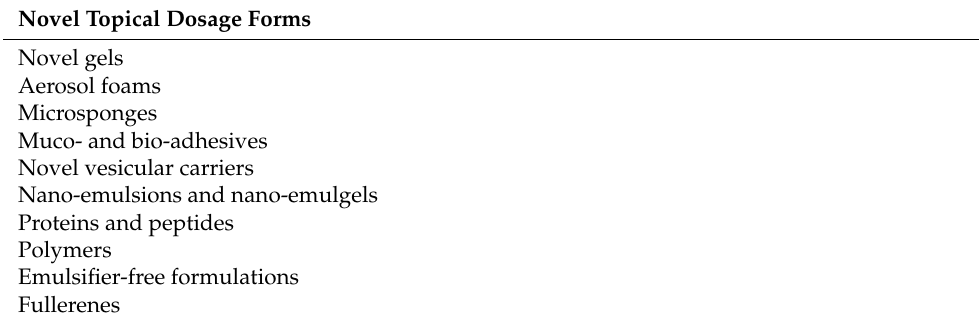
Table 3. Novel topical dosage forms that can be used in miniaturized diffusion cell device. Novel Topical Dosage